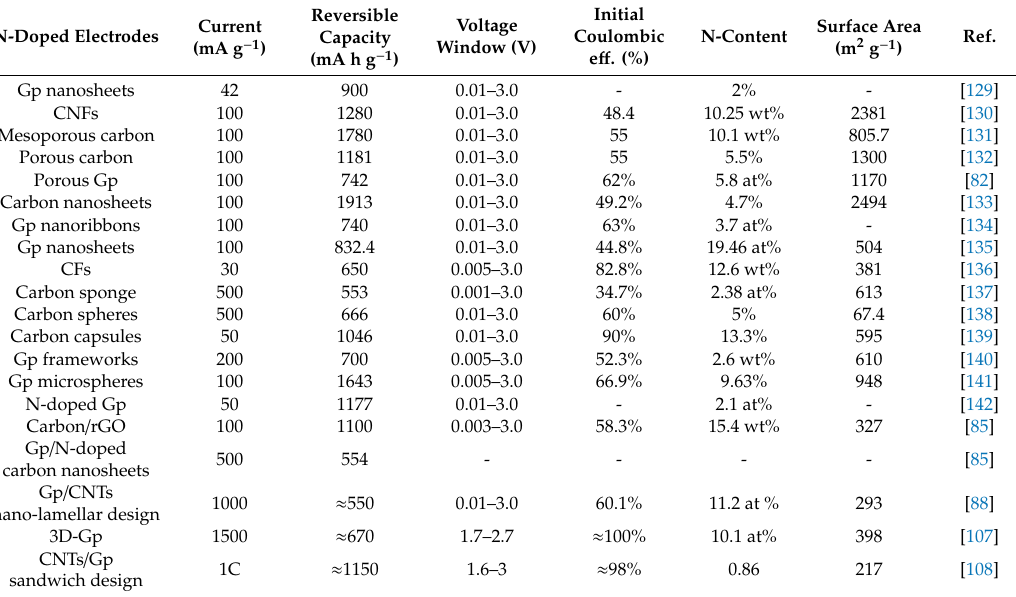
Table 1. Electrical properties of various carbon-based